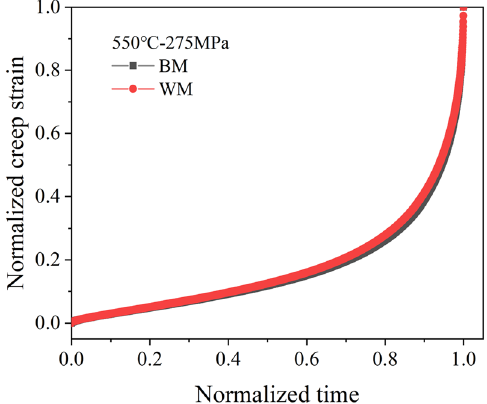
Figure 6: Normalized creep curves of BM and WM using the corre - sponding lifetime and creep rupture strain at 550°C under 275 MPa.